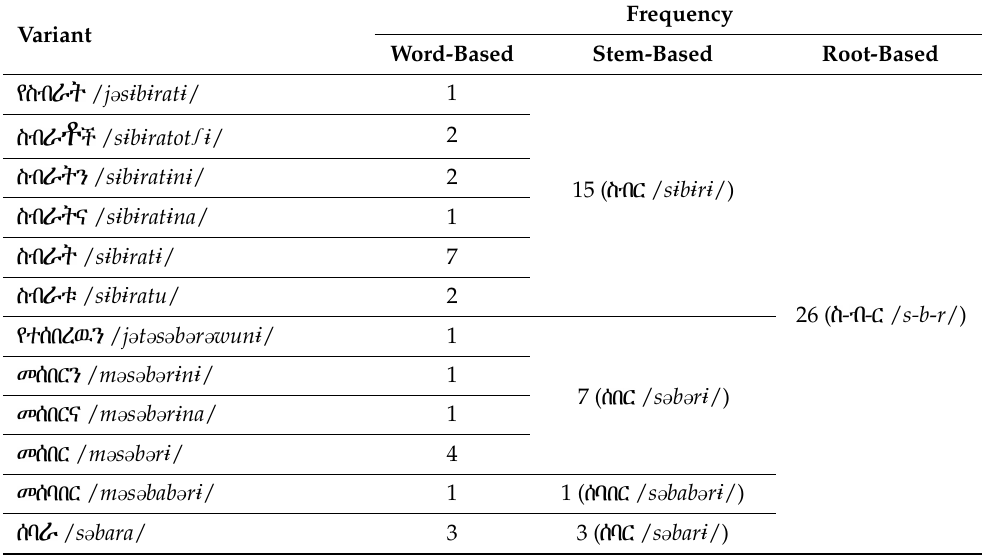
Table 5. Frequency of terms derived from - - / s-b - r / in a sample